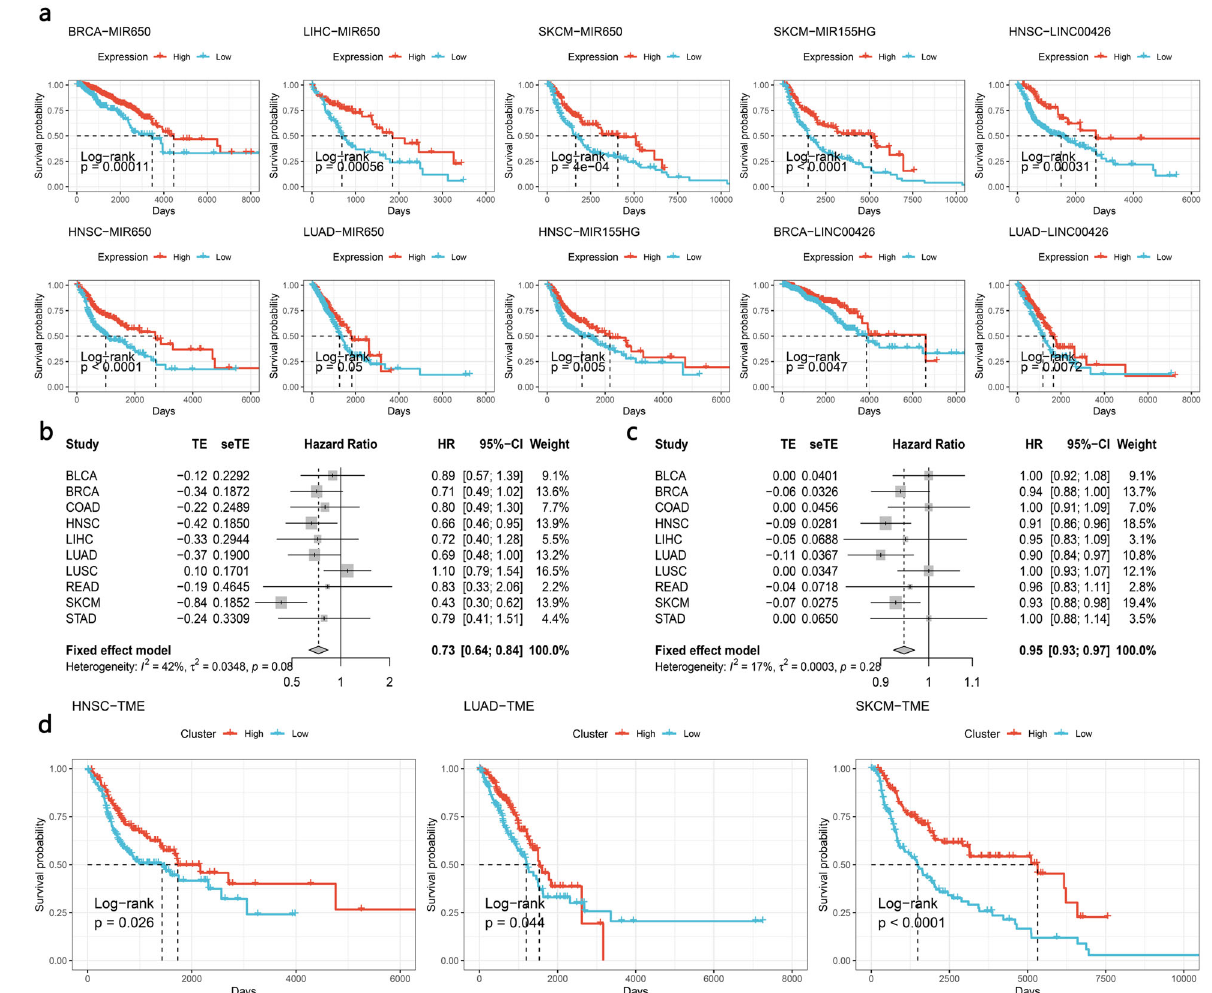
Fig. 7 Prognostic role of immunophenotypes and noncoding RNA. a Kaplan – Meier plots show the overall survival rate for noncoding RNAs. The P value was calculated using the log-rank model. b , c Forest plots show hazard ratios for identi fi ed immunophenotypes. The hazard ratio of b was calculated by a single variable Cox model. c is from the multiple variable cox model. d Kaplan – Meier plots show the overall survival rate for the identi fi ed immunophenotypes. The P value was calculated using the log-rank